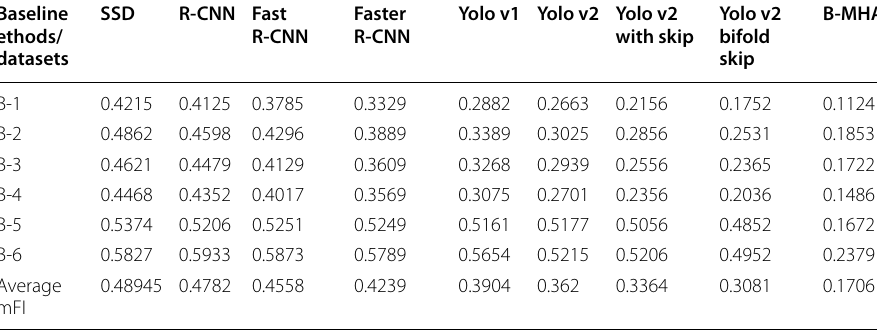
Table 3 Evaluation of the proposed method using mFI Baseline ethods/